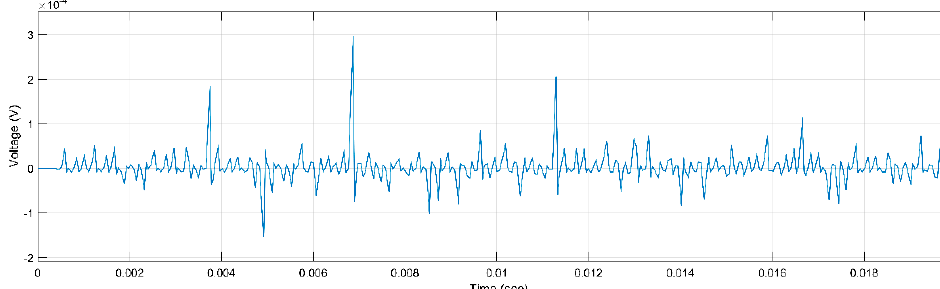
Figure 6. PD Activity for Mica, 5 kV, h, r.